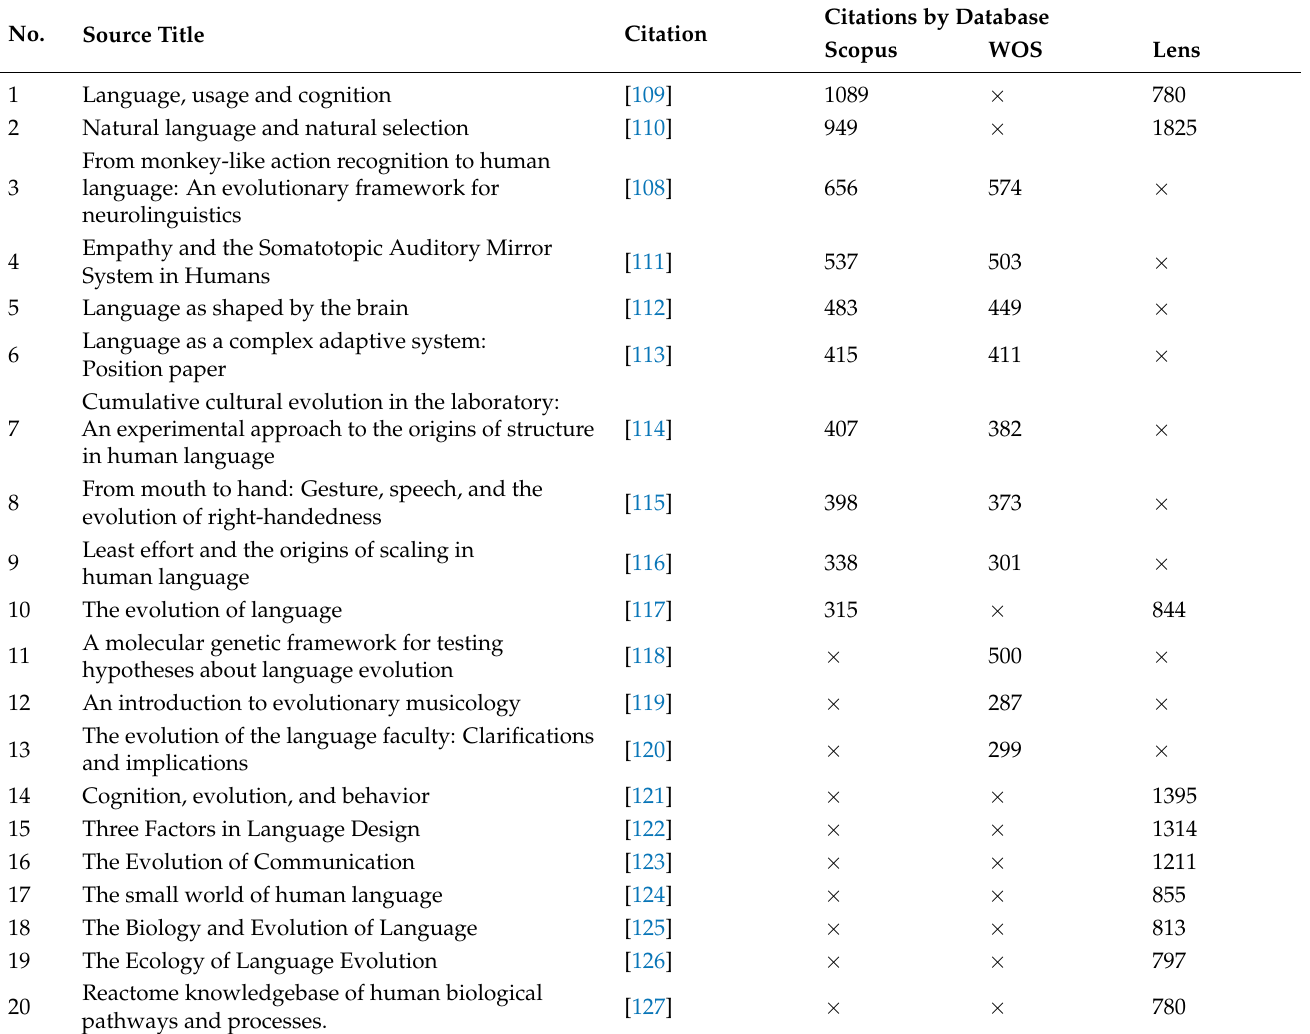
Table 3. Top cited documents of biolinguistics based on citation reports from Scopus, WOS and